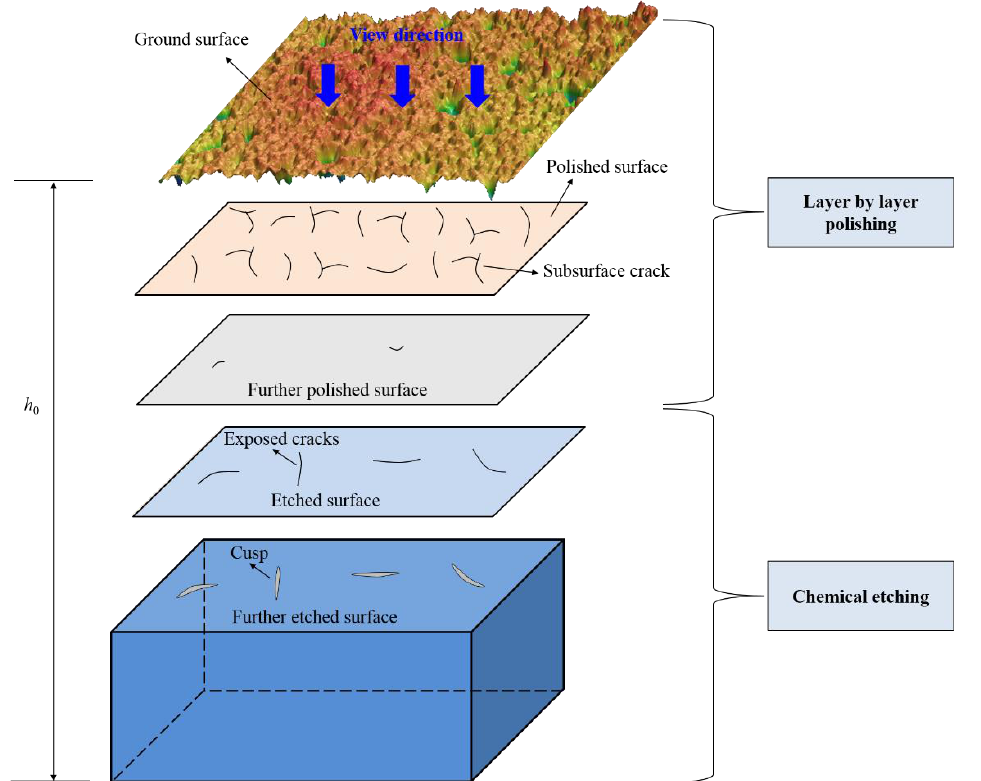
Figure 3. Schematic illustration of layer by layer polishing technology.